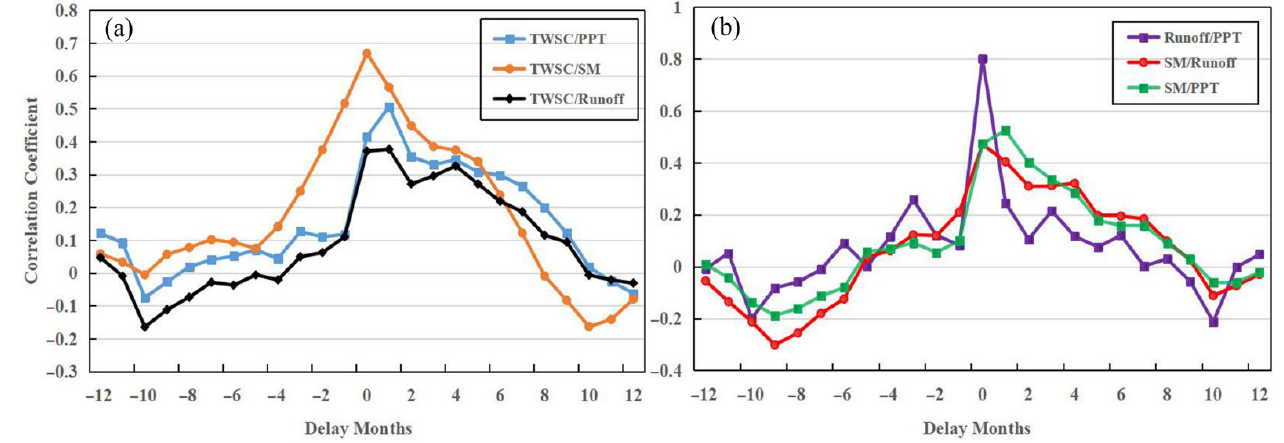
Figure 7. The correlation coefficient and delay months between TWSC, PPT, SM, and runoff anomaly in the UY. ( a ) TWSC and PPT, SM, runoff; ( b ) PPT and runoff, SM, SM and runoff.